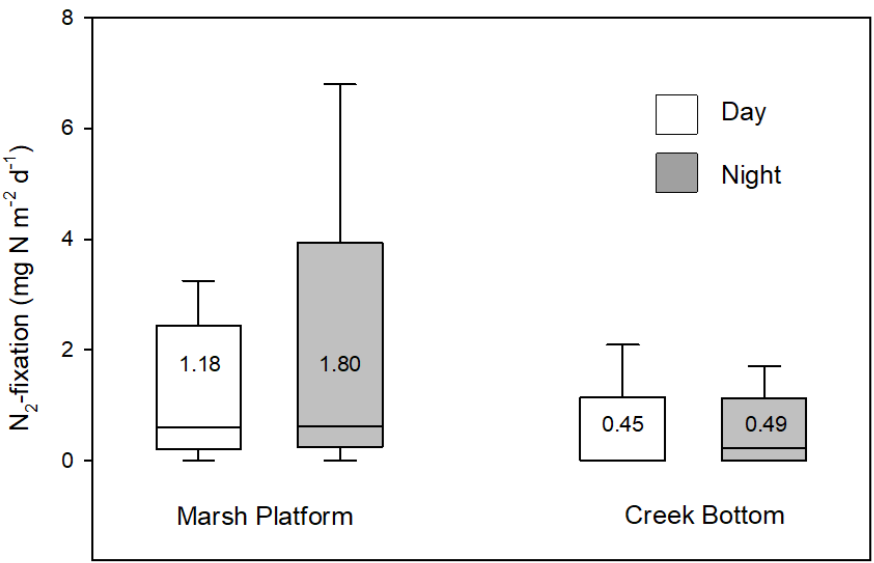
Figure 4. N 2 -fixation rates in July 2017 in Poplar Island marshes ranging in age from 2 to 12 years. Boxes represent the 25th and 75th percentile; the line represents the median, bars represent the minimum and maximum, and the numerical value represents the mean. Differences were not significant ( p = 0.05).